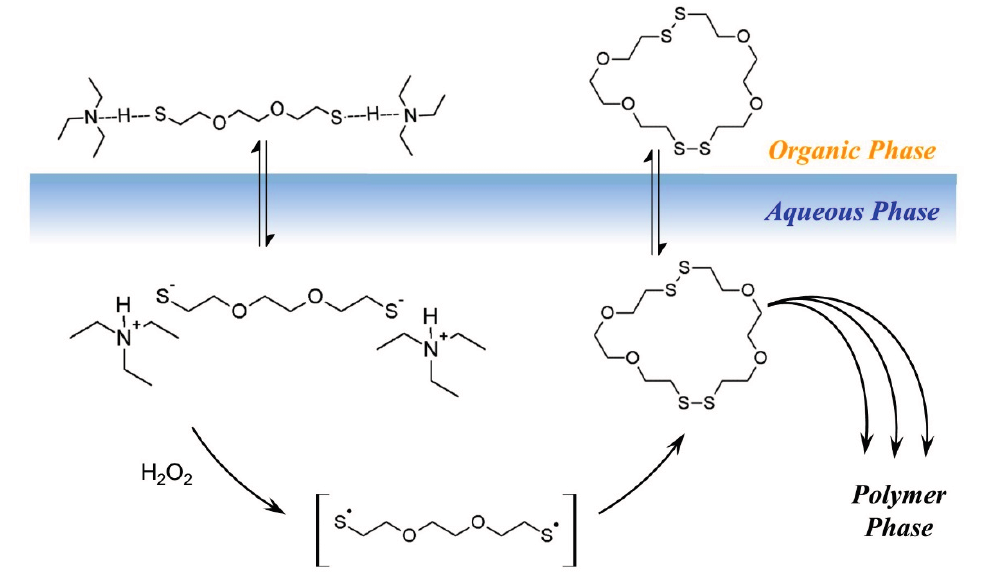
Scheme 3. Cartoon of the R3P phase transfer